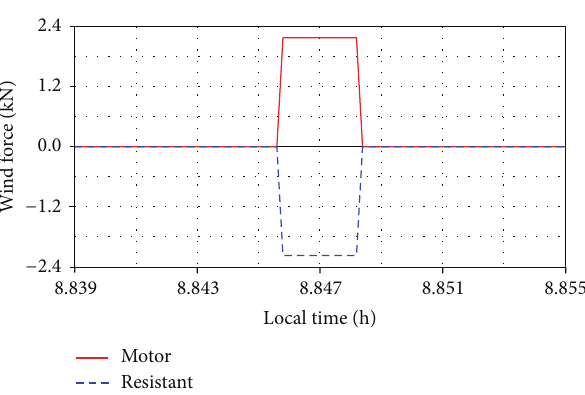
Figure 17: The time-history variation of the applied force: (a)— motor, (b)—resistant.